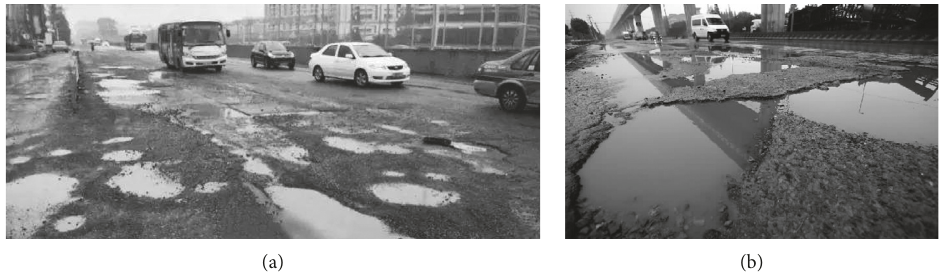
Figure 4: Bad surface condition on Fenghua Road.